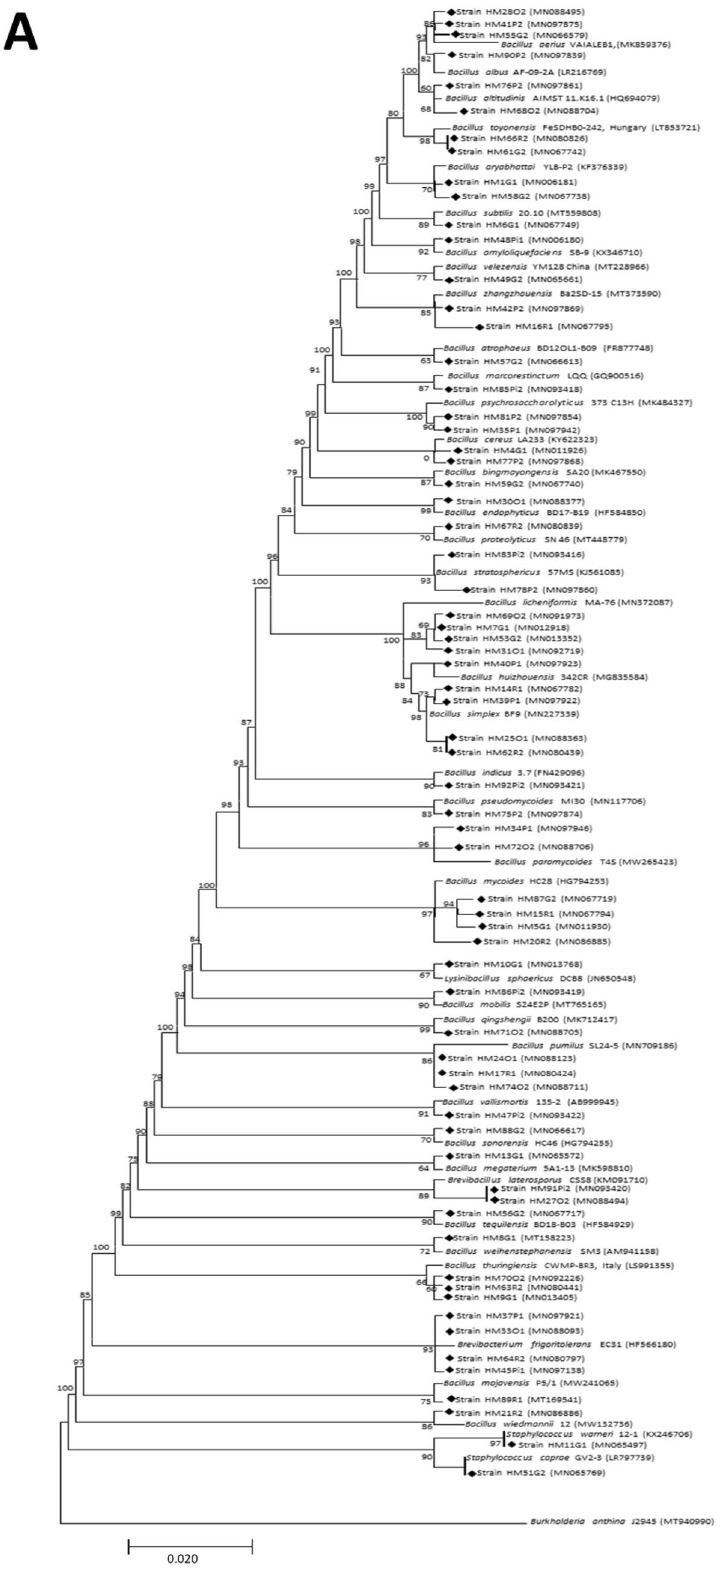
Figure 5. Phylogenetic trees depicting evolutionary relationship of isolated bacterial species from the phylum, Firmicutes (A) and Proteobacteria (B) based on their 16S rRNA gene sequences